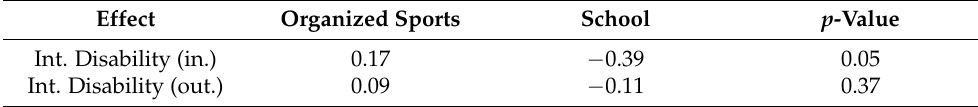
Table 6. Mixed-effects meta-analyses for intellectual disability with the setting as the moderator